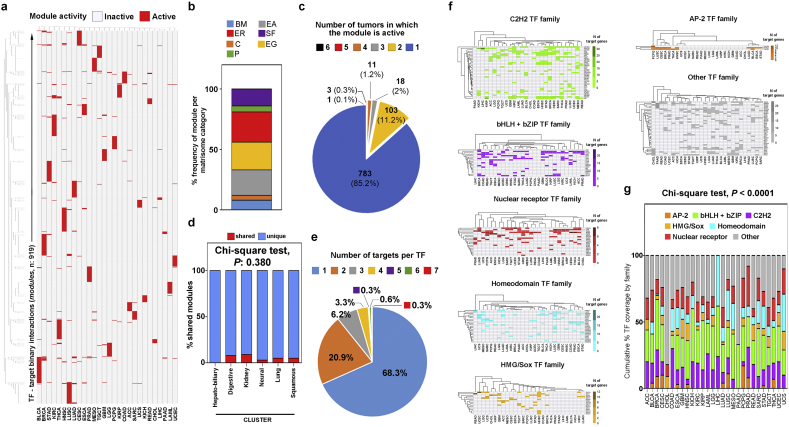
Modular transcriptional control of the matrisome signatures. (a) Heatmap of module activation in each tumor type. A module is defined as the binary interaction (positive Pearson correlation, significantly higher than in any other tumor type) between a transcription factor (TF) and a gene of the matrisome signature of the given cancer. (b) Frequency of modules regulating each matrisome category. (c) Usage of the same module between different tumors is infrequent, and (d) does not depend on clusters. “Shared” indicates a module used by at least 2 tumor types of the same cluster. (e) Number of matrisome targets per each TF identified. (f) Abundance of different members of TF families in each tumor. % TF coverage is the % of modules having the given TF in respect to the total of modules for the given cancer. (g) Cumulative coverage by family. Values sum all the individual TF coverage familywise for the given cancer.